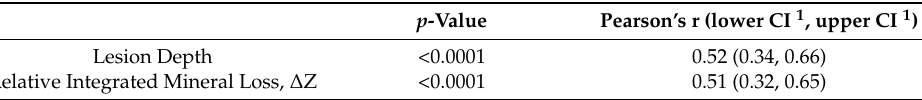
Table 4. p -value, Pearson’s r, and 95% confidence interval for NIR SFE relative raw intensity measurements in the dry condition using 1460-nm light vs. µCT measurements (n = 80).